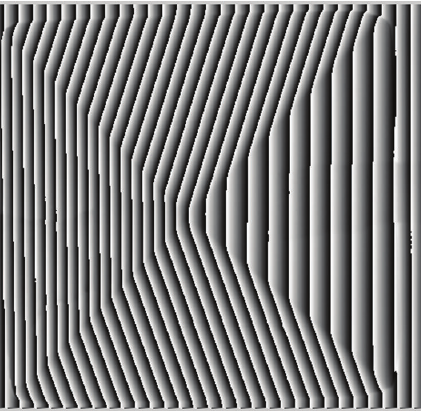
Figure 21: Wrapped phase